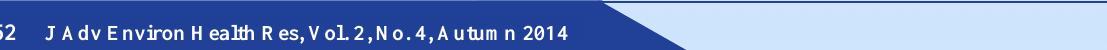
CCE: calcium carbonate equivalent; OM: organic matter; CEC: cation-exchange capacity; EC: electrical conductivity; DTPA: diethylene triamine pentaacetic acid